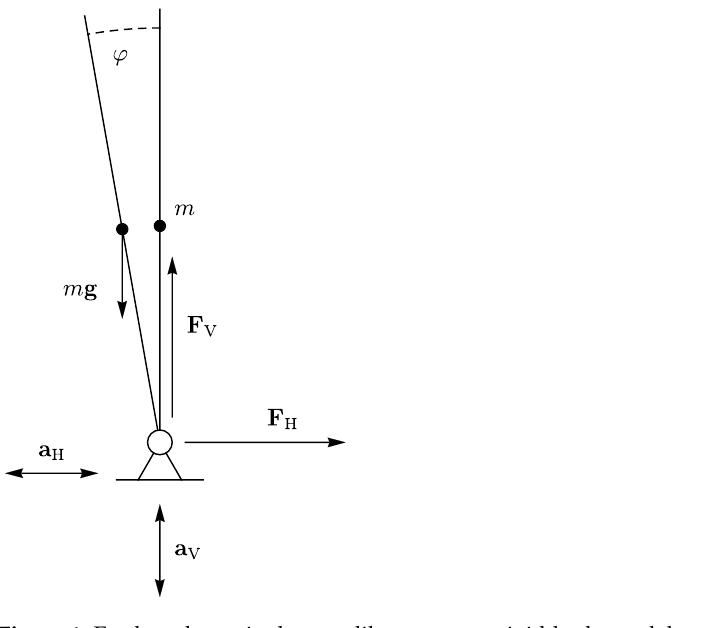
Figure 1. Earthquake excited tower-like structure: rigid-body